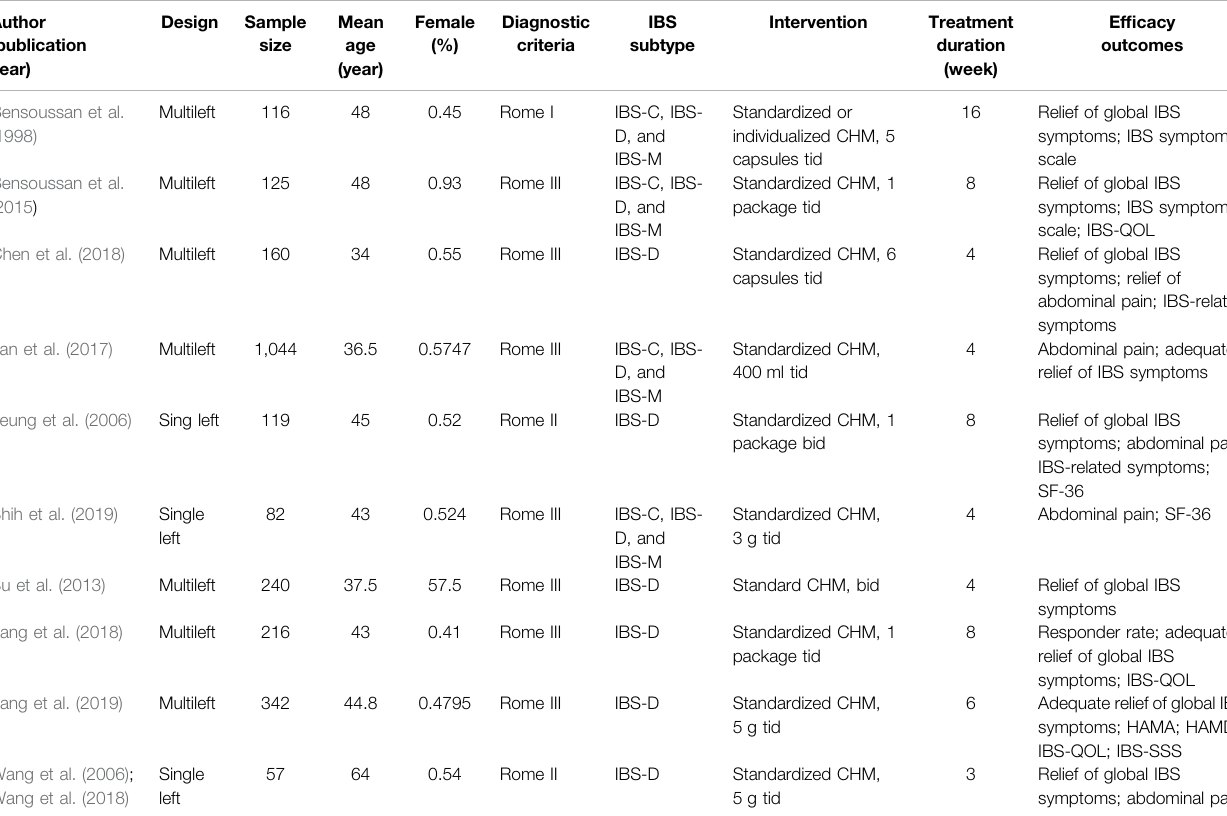
TABLE 1 | Characteristics of the included